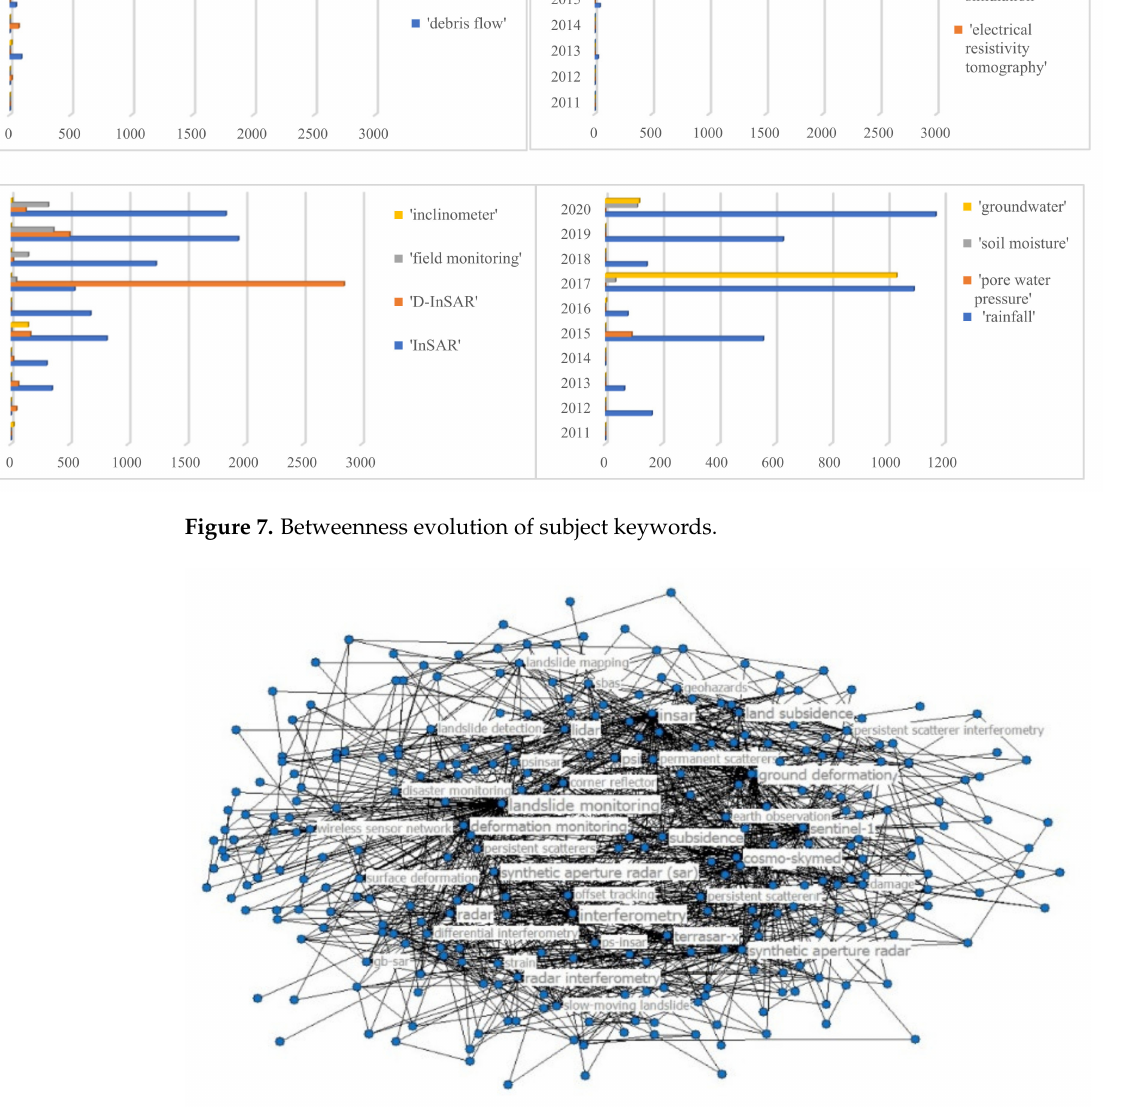
Figure 8. Subcommunities of the high-frequency co-occurrence network for landslide